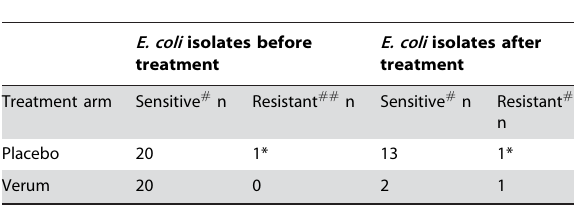
Table 4. Susceptibility analysis of E. coli